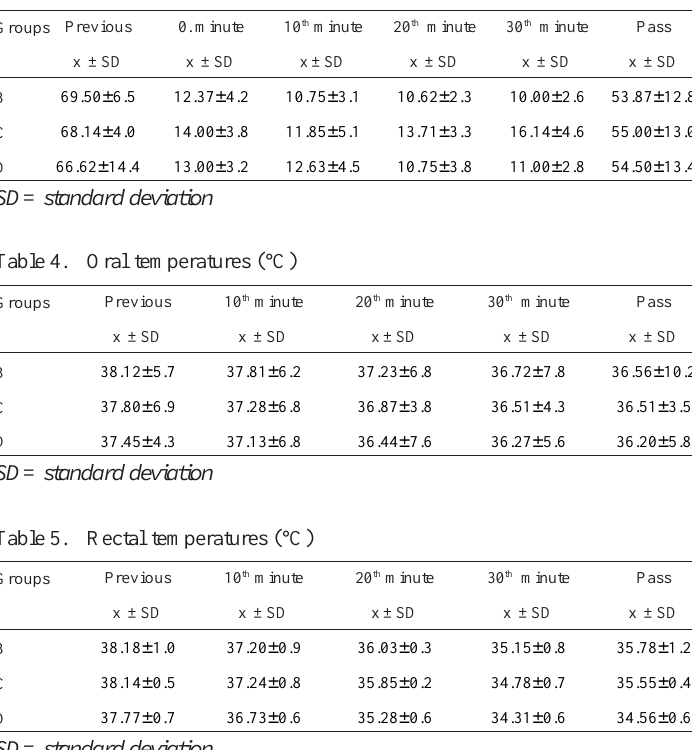
Table 3. Mean distal arterial pressures